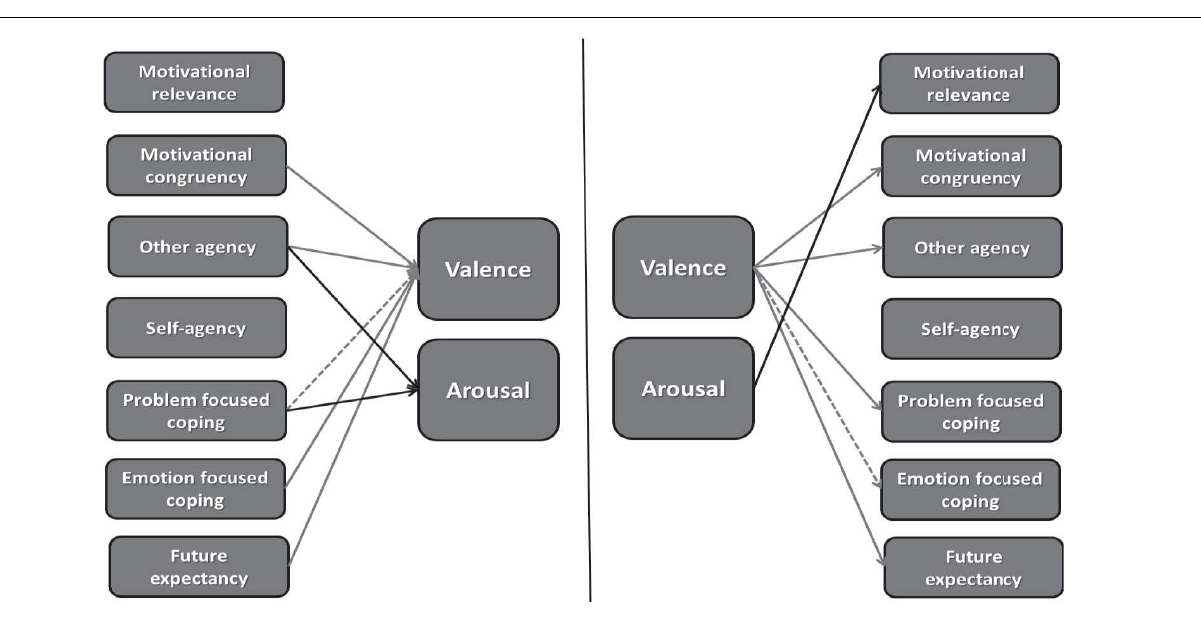
dimension and one appraisal. Full lines represent significant relationships with p < 0.05, dotted lines represent marginally significant relationships with p <